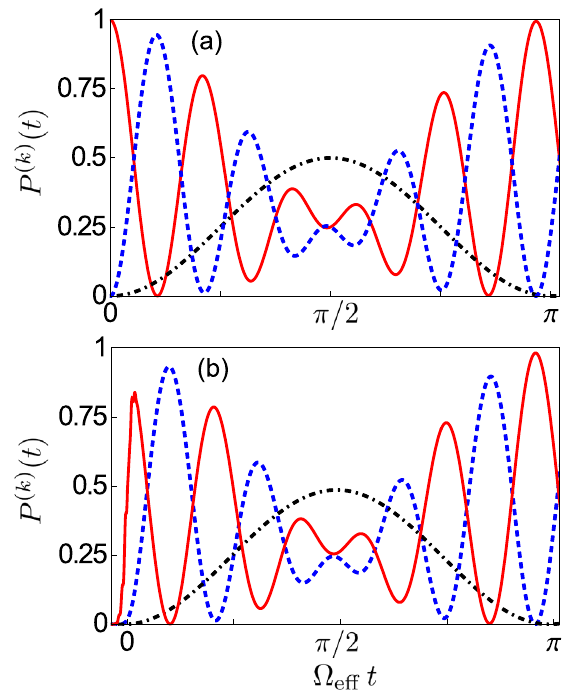
Figure 4. ( a ) Time evolution of the occupation probabilities P ( 1 1 ) ( t ) (red solid curve), P ( 1 2 ) ( t ) (blue dotted curve), and P ( ee ) ( t ) (black dot-dashed curve) with the system initially prepared in the one-photon state given in Eq. (13). As the time evolves, the expected photon hopping between the two weakly-coupled cavities is accompanied by the simultaneous excitation of the two qubits by a single-cavity photon. The maximum π/( 2 � eff ) . The corresponding values P ( 1 1 ) 1 / 2 is achieved at t probability P ( ee ) = =